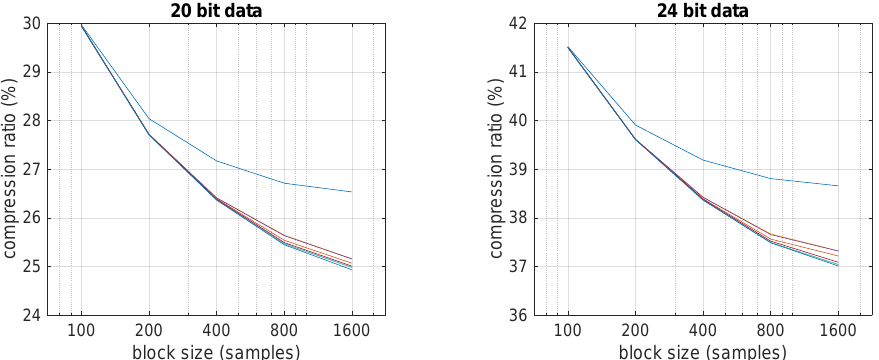
Figure 6. Compression efficiency of FLAC versus block size for different compression levels, from 0 (highest curve) to 7 (lowest curve). Except for very long block sizes, compression levels above 1 have no practical effect on compression ratio. At a sample frequency of 800Hz, these block sizes translate to latencies from 1/8s to 2s, which are still usable for real-time